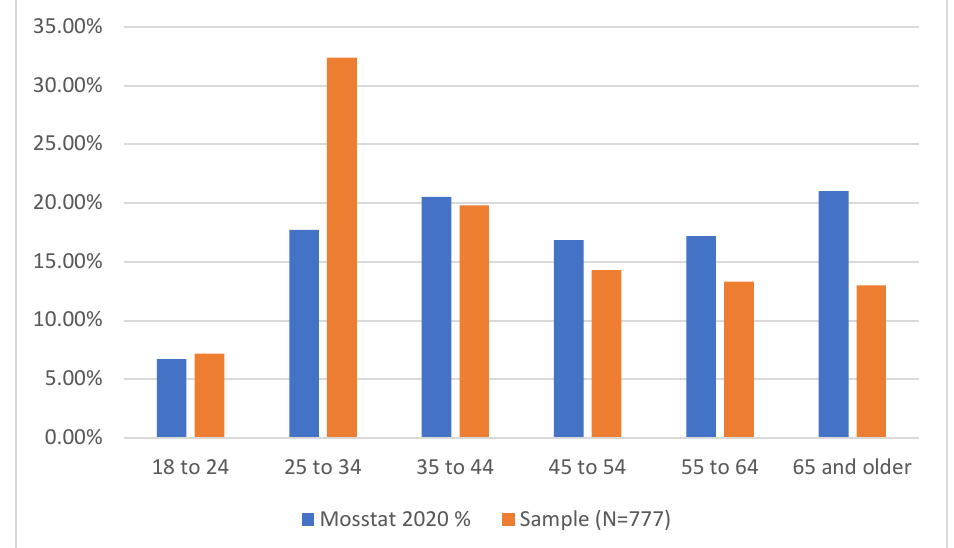
Figure 2. Age distribution of adults (18+) for the Moscow population vs. the sample (N = 777).